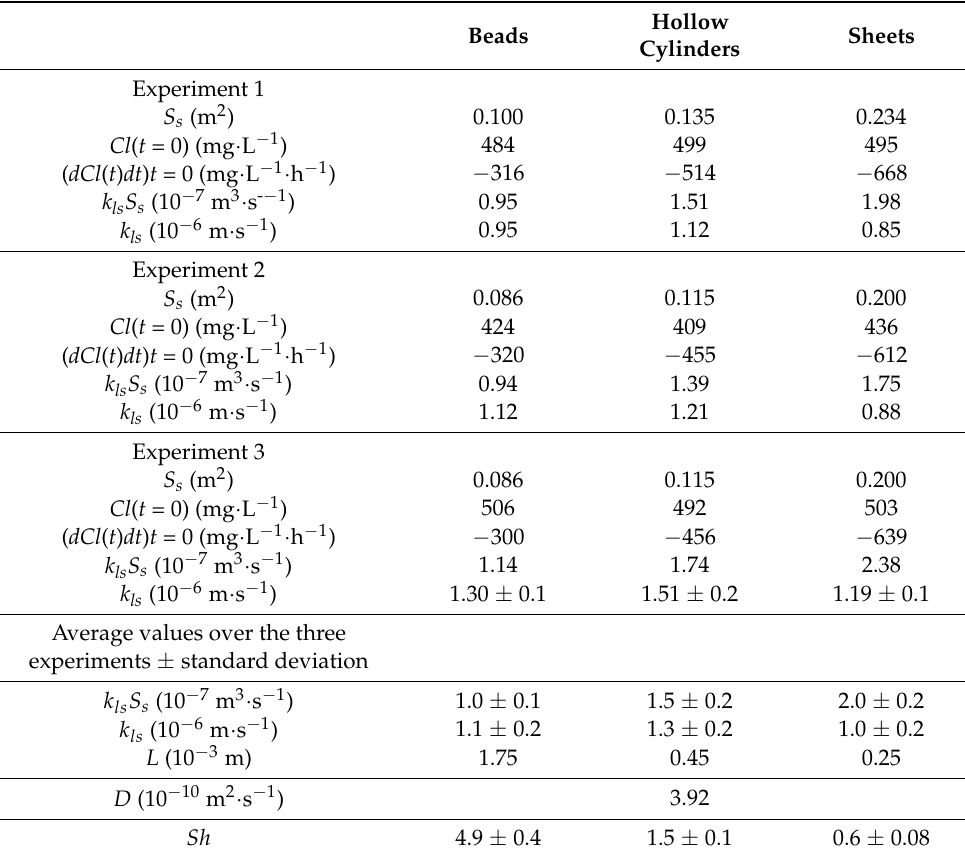
Table 5. External liquid–solid mass transfer parameters for the three media shapes and the three experiments, repeated for each shape. Jar-test experiments (under 90 rpm and solid:liquid ratio of 1:9).